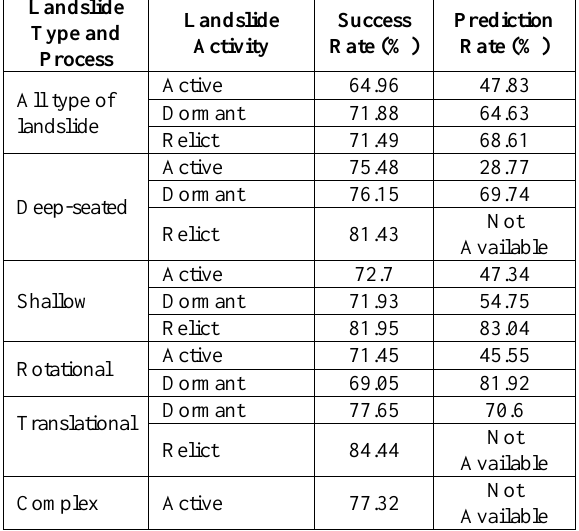
Table 4. Success rate and prediction of the 14 scenarios